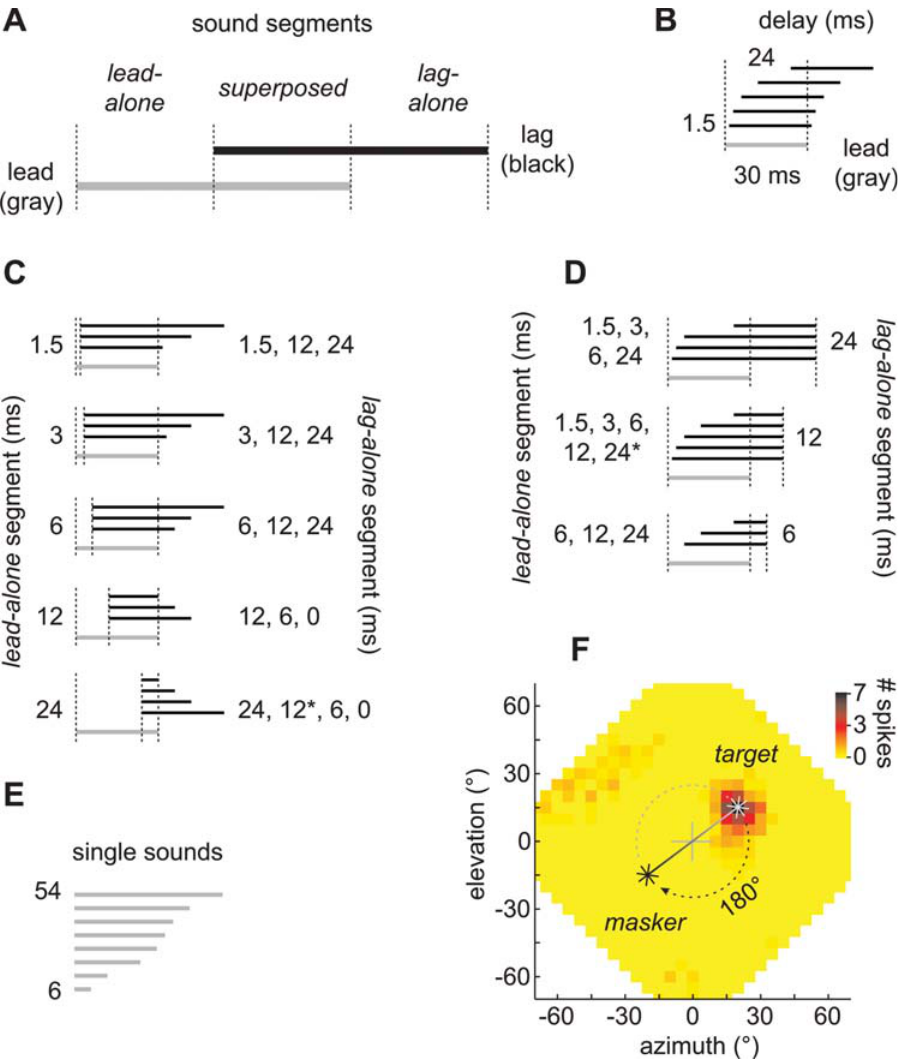
Figure 1. Stimulus configurations. ( A ) Overlapping lead (direct) and lag (simulated reflection) sounds. The temporal overlap defines periods of time during which both sounds were superposed, flanked by periods when the lead or lag sources were present alone. ( B ) Stimuli presented in the standard precedence effect, paradigm. The lead (gray) and lag (black) sounds were of equal length (30 ms) and onset-delay was 1.5, 3, 6, 12, or 24 ms. ( C ) Stimuli in which lag-alone segments were experimentally lengthened or shortened while maintaining a constant duration lead-alone segment (constant lead/lag delay). Lead and lag sounds were of unequal lengths. ( D ) Stimuli in which lead-alone segments were experimentally lengthened or shortened while maintaining a constant duration lag-alone segment (converse of C ). When the lead-alone segment was 24 ms, the length of the lag- alone segment was shortened to 12 ms only in our physiological experiments (indicated by asterisks). ( E ) Single-source sounds among which paired- source stimuli were randomly interspersed in our behavioral experiments. Their durations were roved from 6–54 ms to invalidate duration as a possible cue. ( F ) Placement of sound sources in our physiological experiments. The plot represents the frontal hemisphere of the owl’s auditory space [29]. Positive azimuths and elevations correspond to loci to the right and above an owl, respectively. A cell’s SRF is shown in pseudo-color along with a scale bar indicating the average spike number over 4 repetitions. The source in the optimal location within the cell’s SRF is referred to as the target . A second source placed at a location diametrically opposed across the owl’s center of gaze from the target is referred to as the masker . In the experiments, the target or masker could lead, allowing us to examine a cell’s response to simulated direct sounds and echoes.